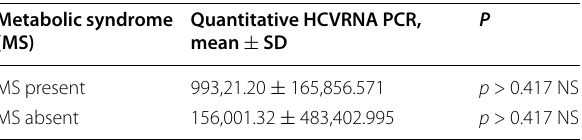
Table 5 Relation between metabolic syndrome and level of HCV